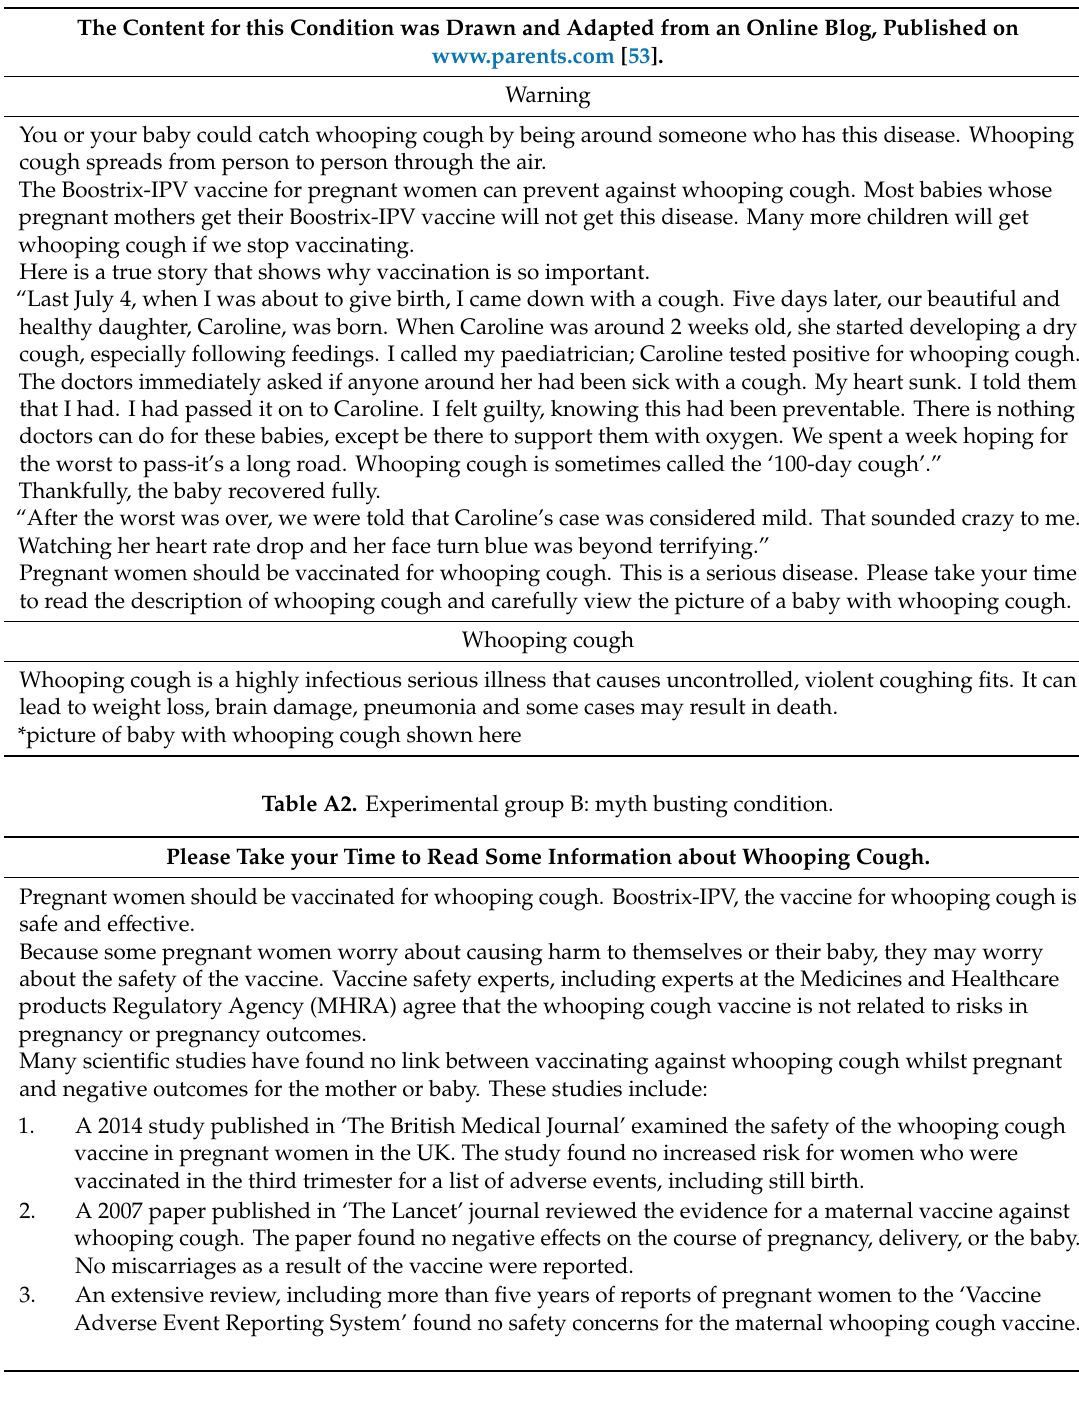
Table A1. Experimental group A: disease risk condition.